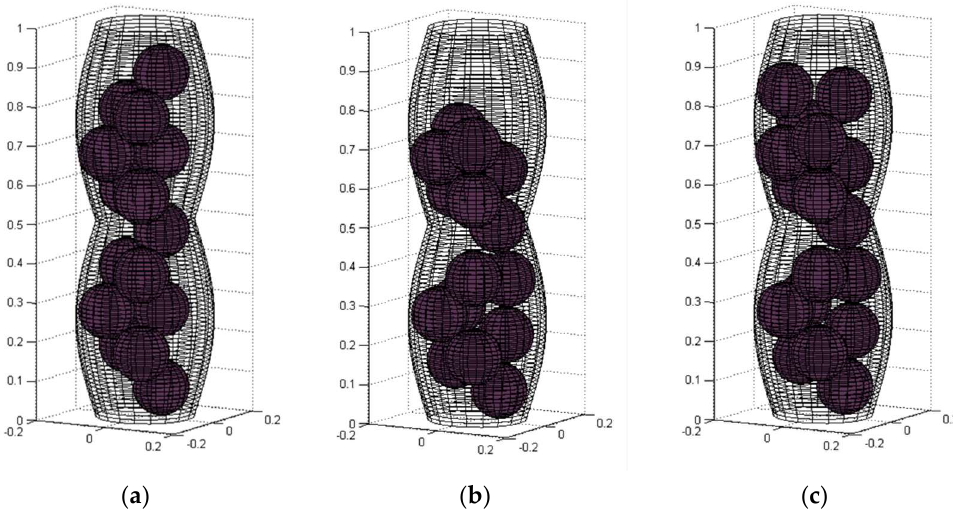
Figure 3. Results of the sphere packing simulation for a constricted wave channel with D max = 0.35, D min = 0.25, r = 0.07: ( a ) the fcc non-random disposition ( N = 15 spheres, APF = 30.76%), ( b ) after the shaking and gravity procedures, and ( c ) final packing, additional spheres were aggregated ( N = 17 spheres, APF = 34.87%).